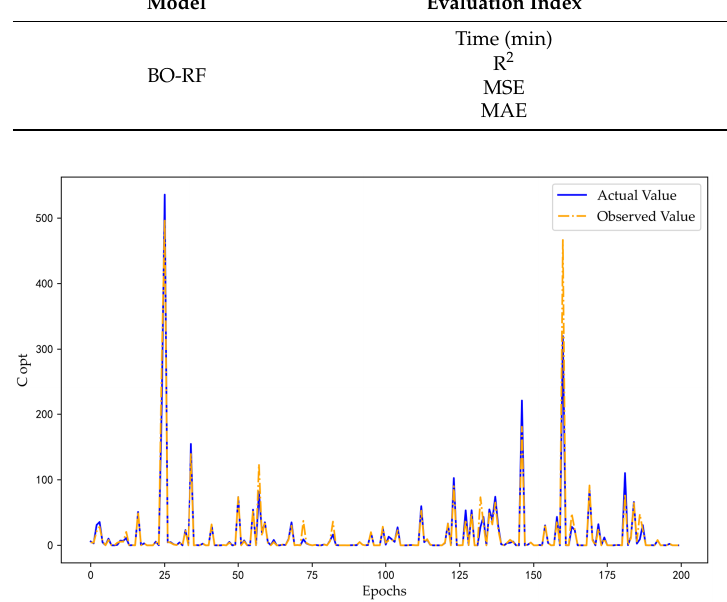
Figure 7. Schematic diagram of BO-RF model.